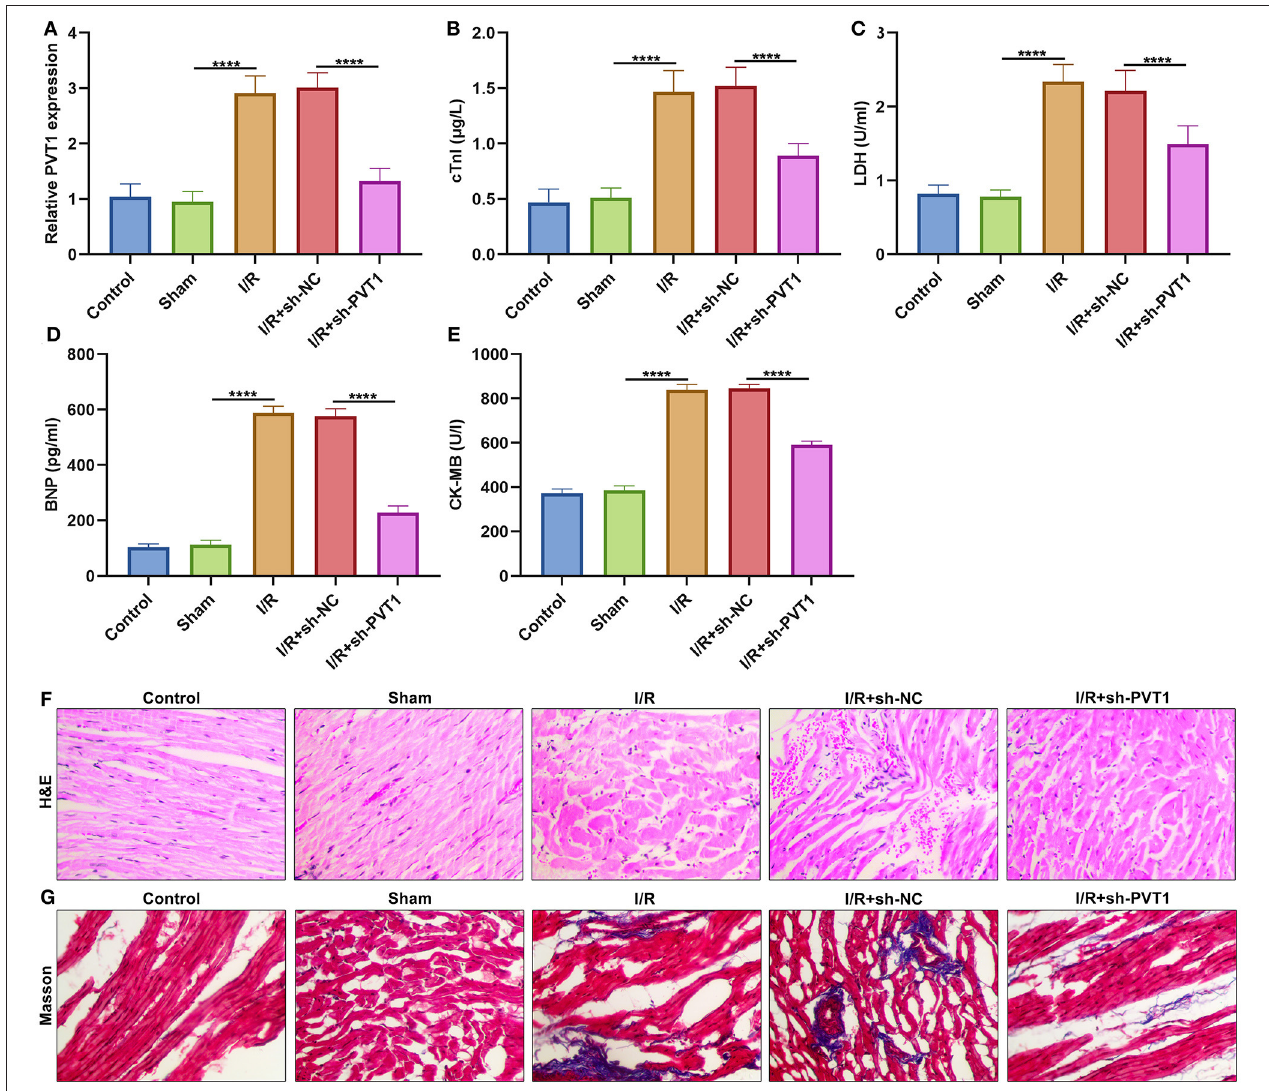
FIGURE 1 | LncRNA PVT1 is up-regulated in myocardial I/R tissues and silencing PVT1 alleviates myocardial I/R damage. (A) RT-qPCR of the expression of lncRNA PVT1 in myocardial tissues in five groups: control, sham, I/R, I/R + sh-NC, and I/R + sh-PVT1 groups. Mice in the I/R + sh-NC and I/R + sh-PVT1 groups were injected by 10 µ L sh-NC or sh-PVT1 via Lipofectamine 2000 reagent. After 48h, myocardial I/R model was constructed. No treatment was done for mice in the control group. The chest of mice in the sham operation group was only opened, but was threaded the corresponding part without ligating the LAD. There were